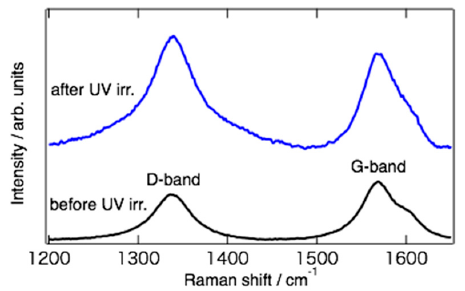
Figure 3. Raman spectra observed for polyvinyl 4-(chloromethyl)benzoate/MWCNT before and after ultraviolet irradiation.